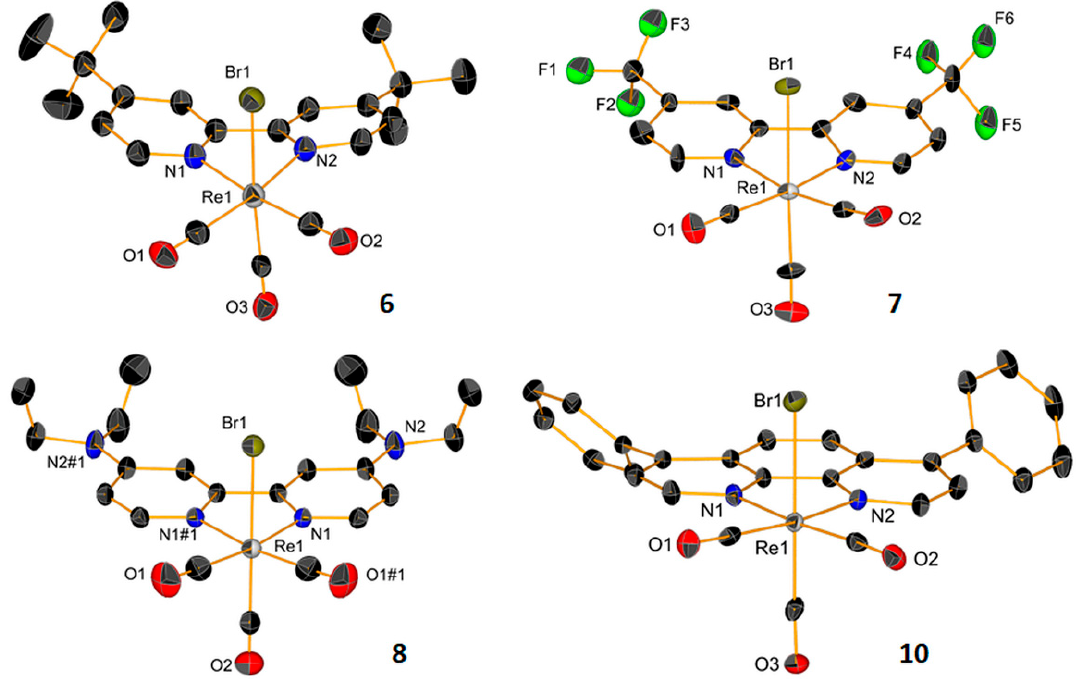
Figure 3. ORTEP representations of the crystal structures of Re tricarbonyl complexes 6 – 8 and 10 . Thermal ellipsoids are at 30% probability. Hydrogen atoms are omitted for clarity.